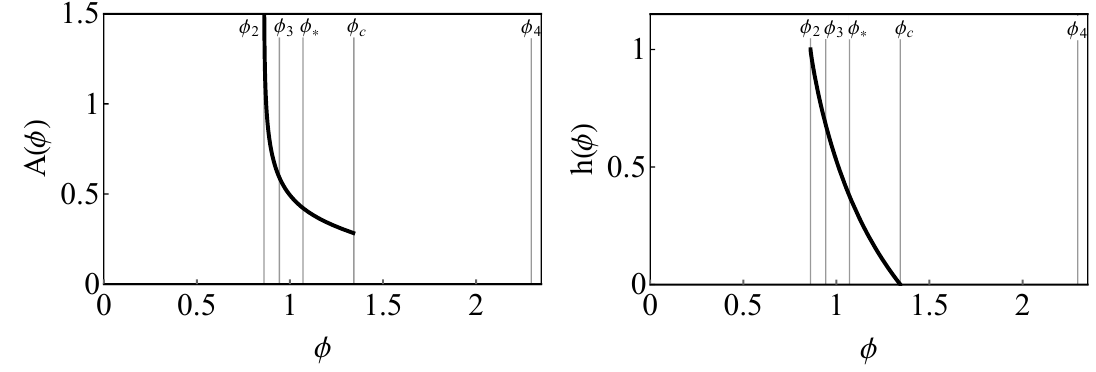
Figure 8 . Numerical solution describing the thermal state with non-zero VEV in the CFT 2 . This (cid:13)ow may be obtained either as the limit (cid:30) H ! (cid:30) +